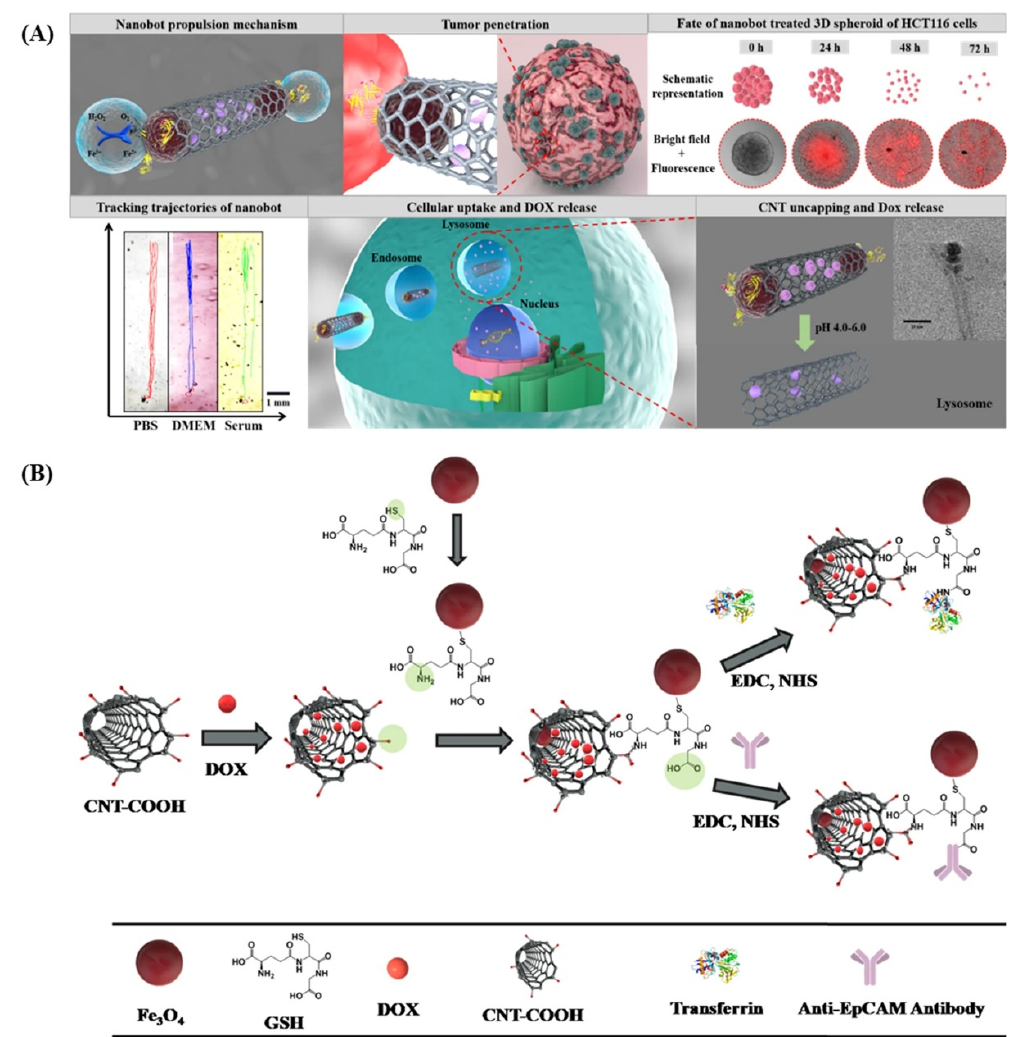
Figure 5. ( A ) Schematic representation of the oxygen-induced autonomous propulsion mechanism and deep penetration of nanobots in the tumor, the fate of 3D spheroids treated with nanobots, trajectories of nanobots in physiologically relevant media, followed by an illustration of the DOX- loaded nanobot targeting the transferrin/EpCAM receptor and entry into cancer cells, and, finally, the mechanism of triggered drug release under acidic endo/lysosomal conditions. ( B ) Schematic illustration of the step-by-step synthesis of CNT-DOX-Fe 3 O 4 -Tf/CNT-DOX-Fe 3 O 4 -mAb. Reproduced from [174], under a Creative Commons